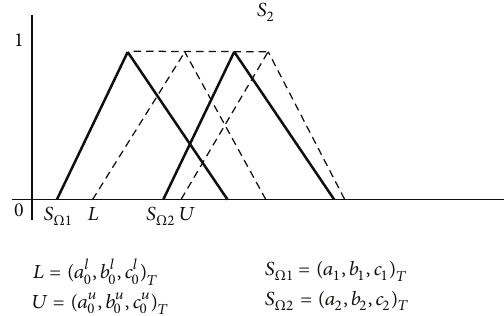
Figure 4: Graphical representation of confidence interval for 𝐻 2 (graph for 𝑆 2 ).